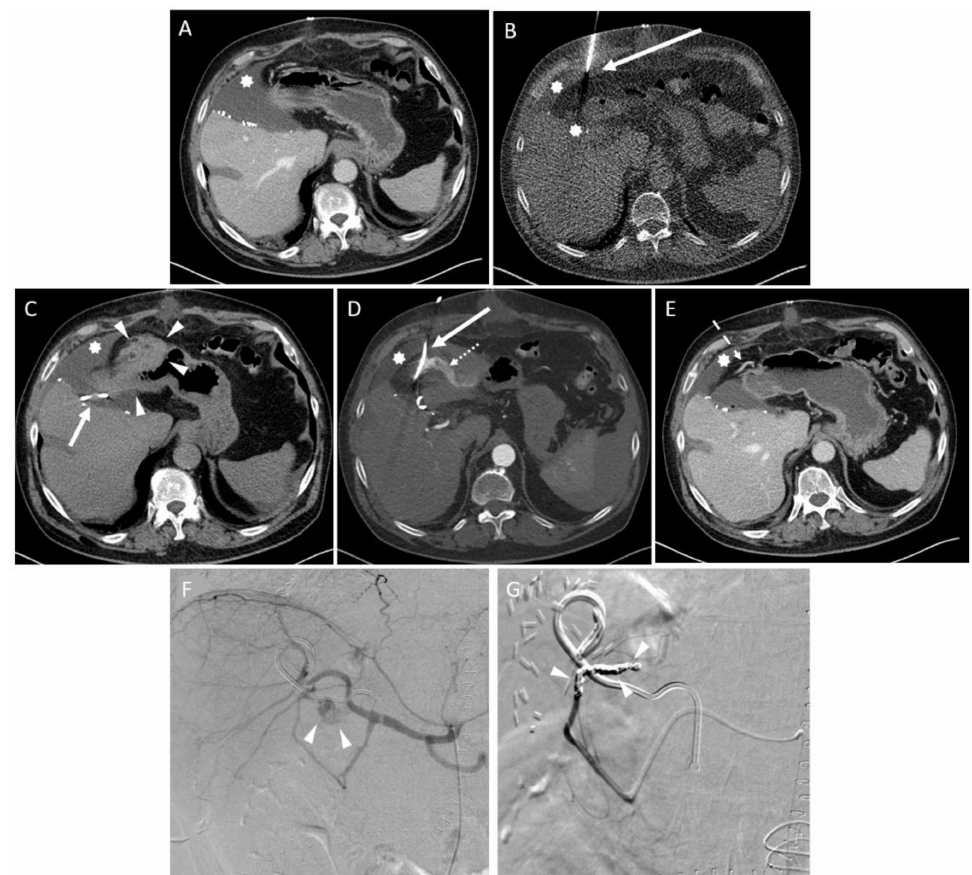
Figure 3. Example of an intervention with complications according to SIR. ( A ) A 72-year-old male after left side hemihepatectomy due to a cholangiocellular carcinoma. Thirteen days after the operation, the patient presented with fever, epigastric pain and elevated inflammatory blood parameters. CT revealed a large fluid collection in the resection area (star). ( B ) CT fluoroscopy-guided placement of a 10 F drainage (arrow) within the fluid collection (star). ( C ) Unenhanced CT post-interventional control scan showed blood collections in the paragastric area and in the right upper quadrant (arrowheads). Arrow: drainage. Star: fluid collection. ( D ) An additional CT scan with arterial contrast revealed extravasation (dotted arrow). Arrow: drainage. Star: fluid collection. ( E ) Workup of the incident showed an injury of the right gastroepiploic artery (dashed arrow). The reason was a restless and uncompliant patient. Due to patient movements, the trajectory was not carried out as planned. Star: fluid collection. ( F ) An immediately performed digital subtraction angiography (DSA) confirmed extravasation of contrast agent from the right gastroepiploic artery (arrowheads). ( G ) Treatment of the bleeding was performed with an endovascular placement of seven microcoils in a sequence